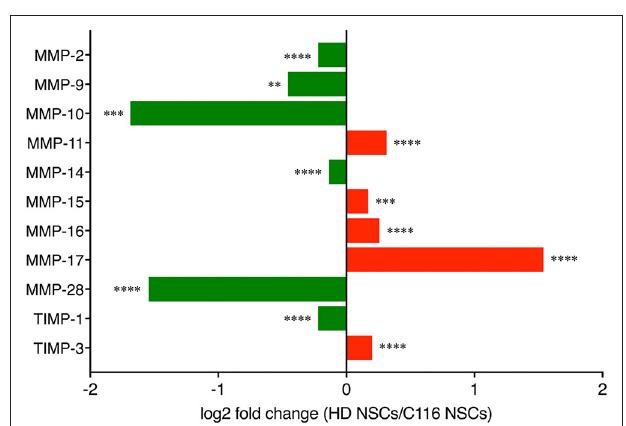
FIGURE 1 | RNA-Seq analysis. RNA-Seq analysis of MMP and TIMP expression in HD- vs. corrected C116-NSCs via IPA analysis reveals